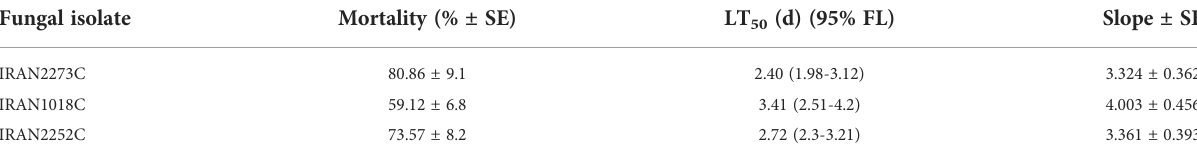
TABLE 2 Cumulative mortality and LT 50 values calculated for entomopathogenic fungi against A. obtectus adults exposed at the concentrations used in the experiments (1.7×10 5 , 2.3×10 5 and 7.9×10 5 conidia ml -1 for IRAN2252C, IRAN2273C, IRAN1018C isolates, respectively). Fungal